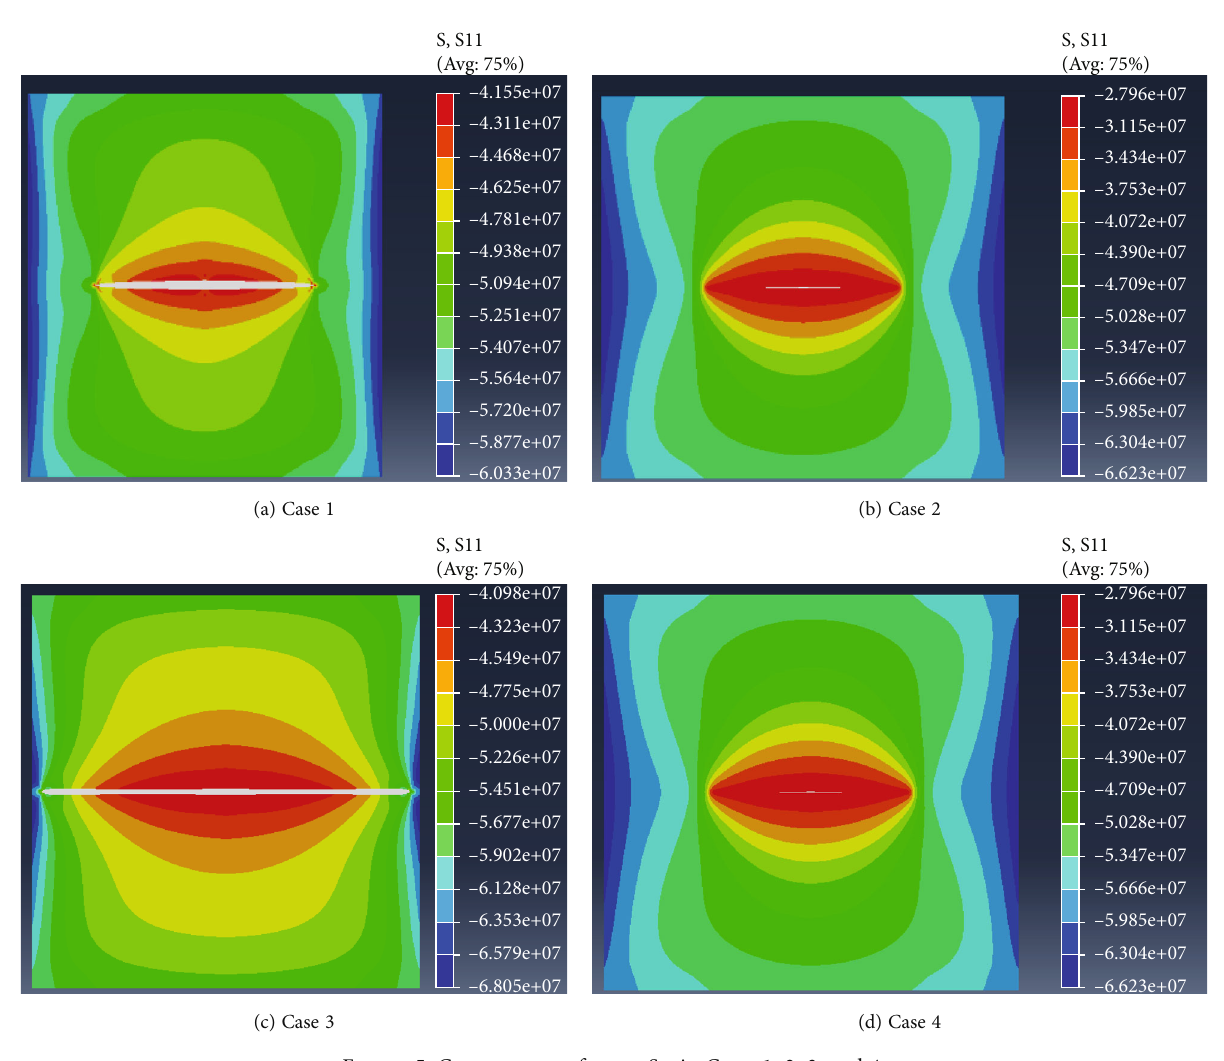
11 in Cases 1, 2, 3, and